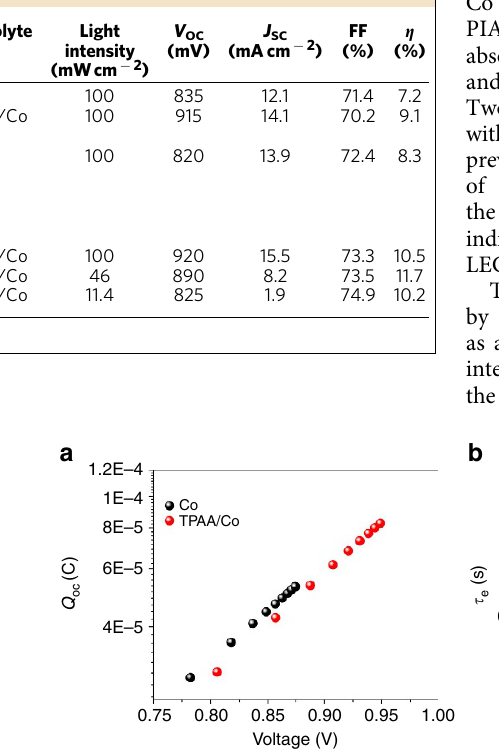
Table 1 | Photovoltaic performance of DSSCs based on the LEG4 dye and co-sensitizer with varied electrolytes and varied light intensity (AM 1.5 G spectral distribution and aperture area 0.25 cm 2